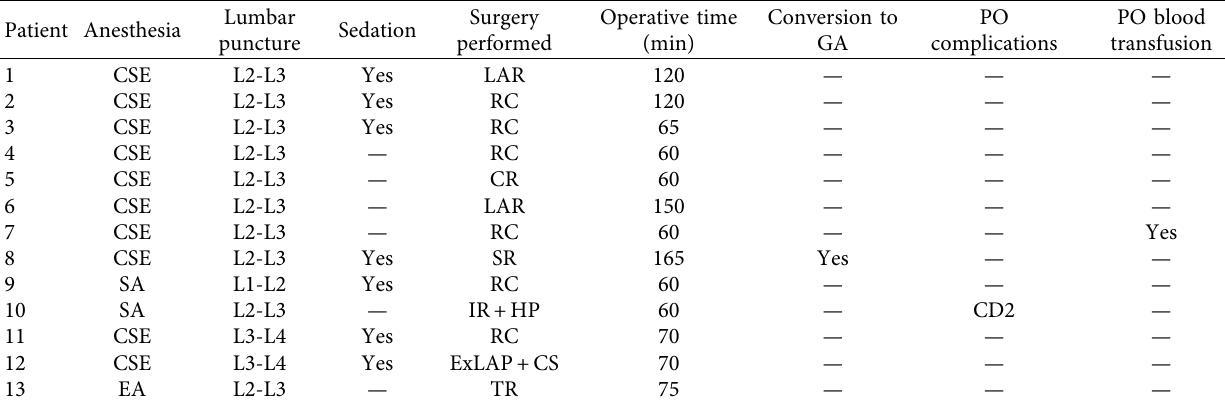
Table 2: Regional anesthesia and perioperative results.